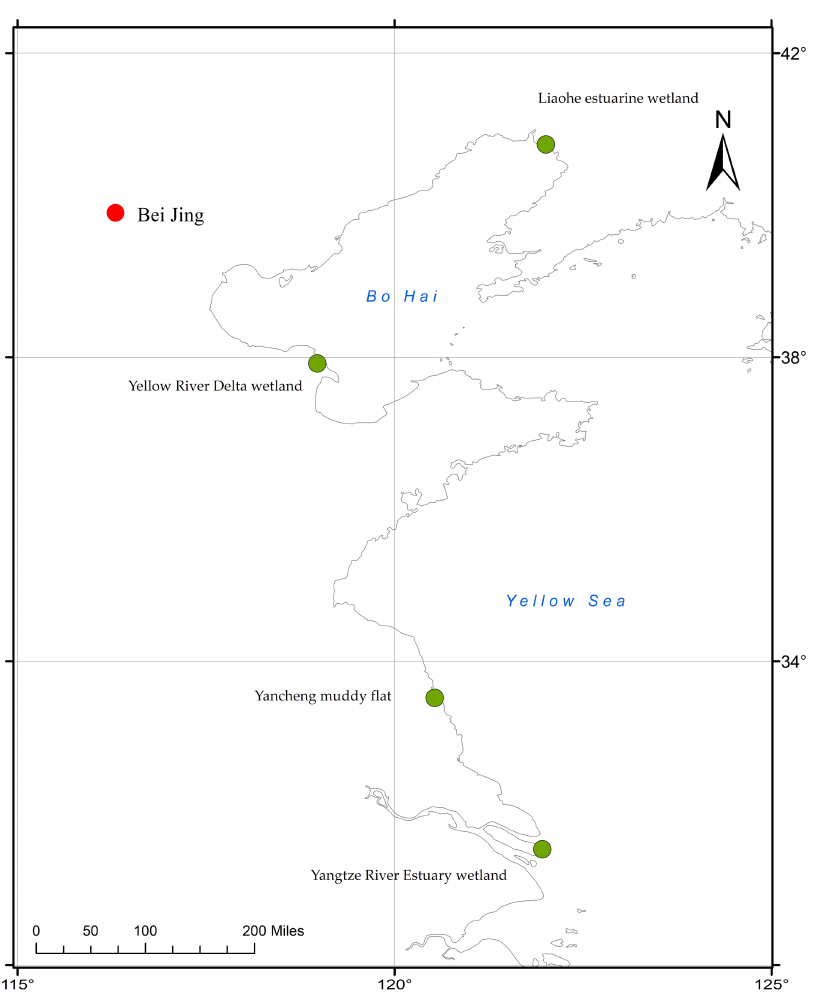
Figure 1. Map of study area. Green points represent four main study